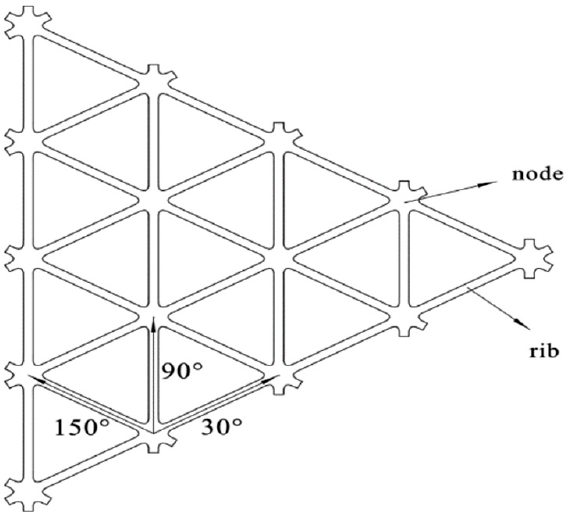
Figure 1. Basic structure of triaxial geogrid.